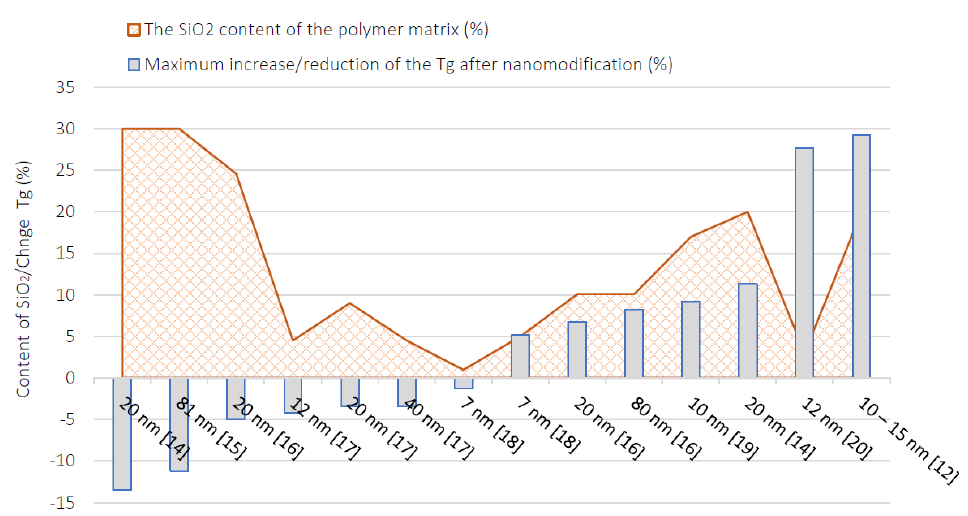
Figure 2. The glass transition temperature (Tg) of obtained FRP composites for different contents of SiO 2 . Literature review [12,14–20] for different diameters of nanosilica: 7–81 nm.